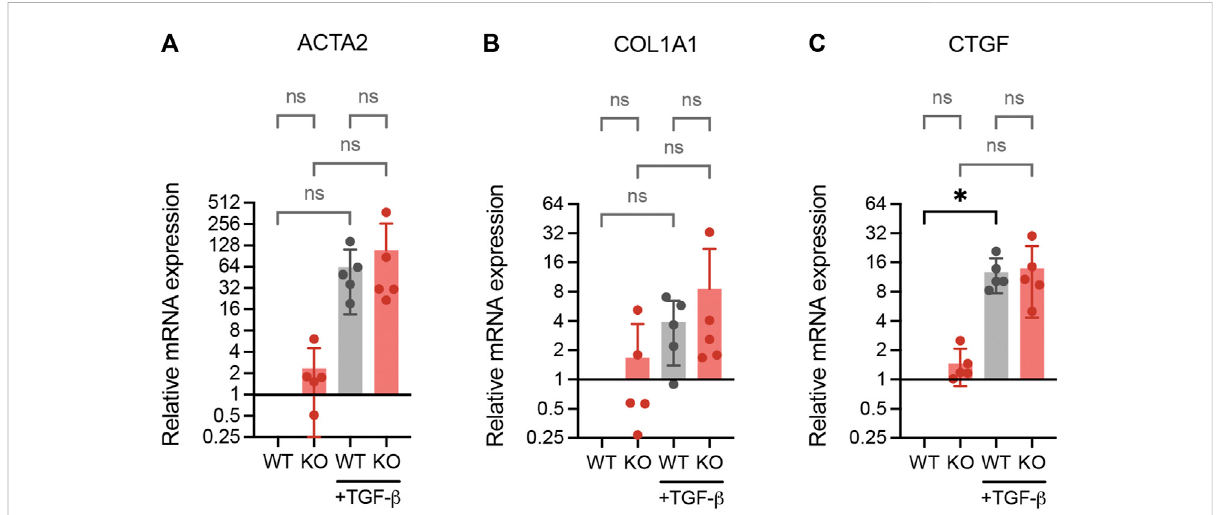
FIGURE 6 RNA expression analysis (qPCR) of fi brotic genes ACTA2 (A) , COL1A1 (B) and CTGF (C) in WT and DPP4-KO lung fi broblasts cultured with or without TGF- β 1 (2 ng/ml) supplemented media for 24 h ( n = 5). Data is presented as relative expression compared to unstimulated WT control. Bars represent mean. For statistical analysis, a mixed-effects analysis with Tukey ’ s multiple comparisons test was used. * p <